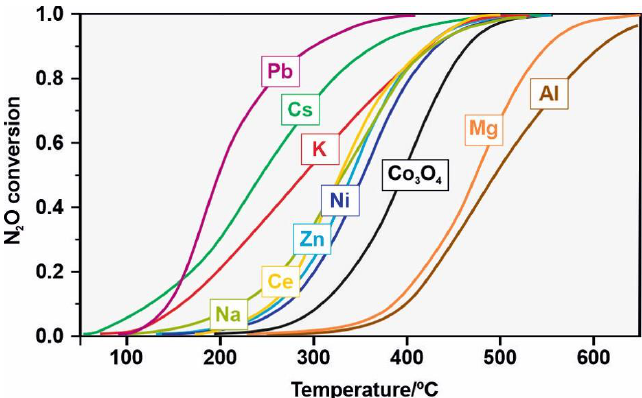
Figure 1. The N 2 O conversion curves as a function of temperature for the bare and cobalt spinel-doped with Na, K, Cs, Mg, Al, Pb, Ni, Zn, and Ce, at specific optimal concentrations.